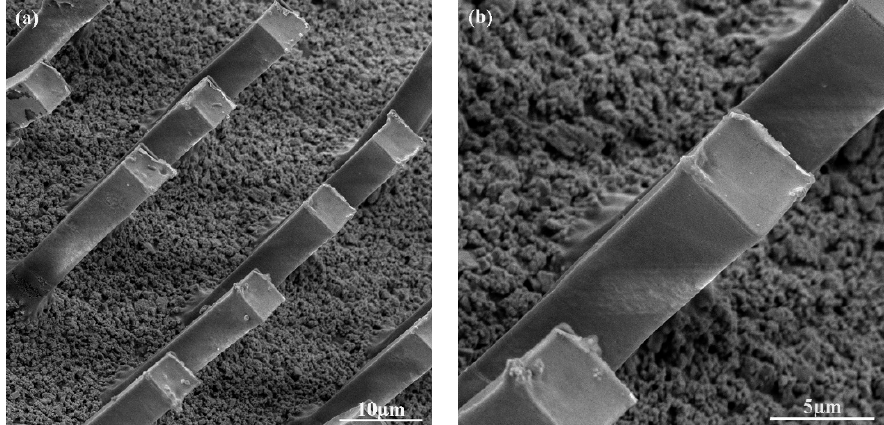
Figure 11. SEM images of the green KNN pillar arrays with a low magnification ( a ) and a high magnification ( b ).